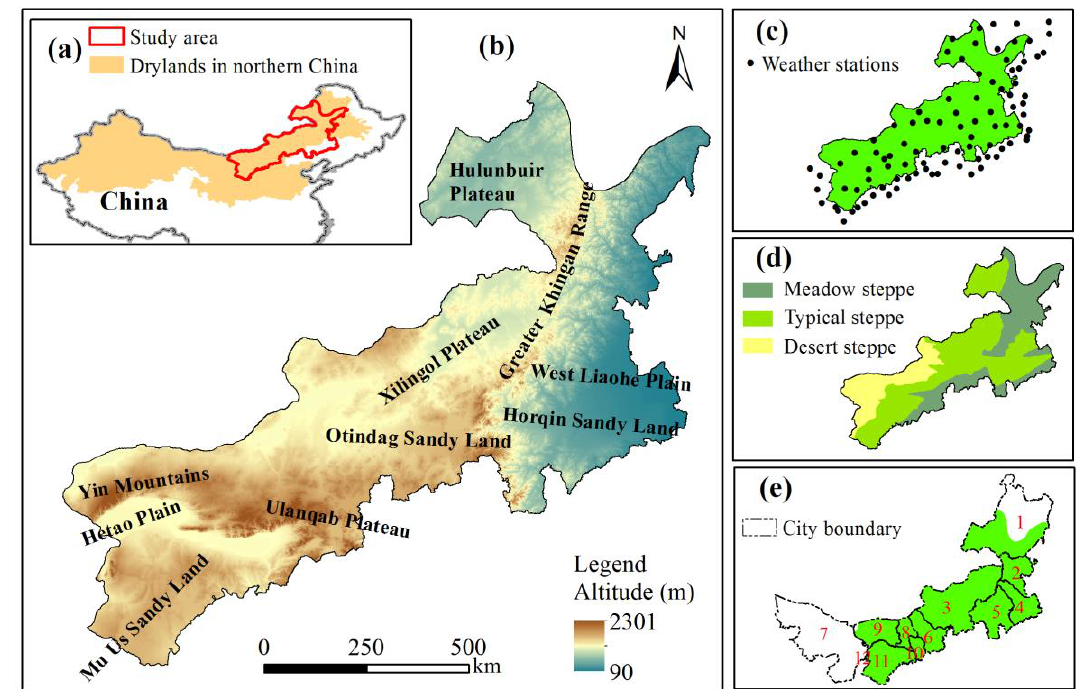
Figure 1. ( a ) Location of the study area, ( b ) topographical conditions, ( c ) weather station distribu- tion, ( d ) ecoregions of the study area, and ( e ) city boundaries. The numbers in ( e ) represent the